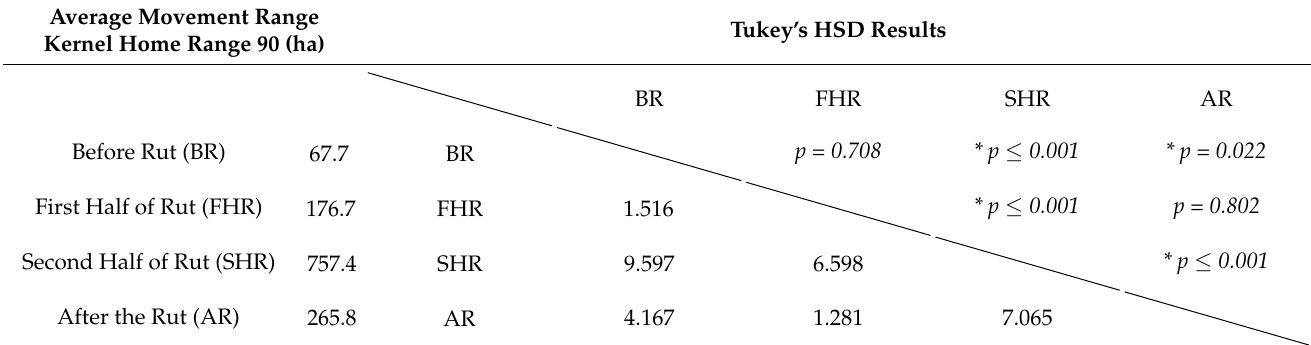
Table 3. The result of analysis of average movement range.